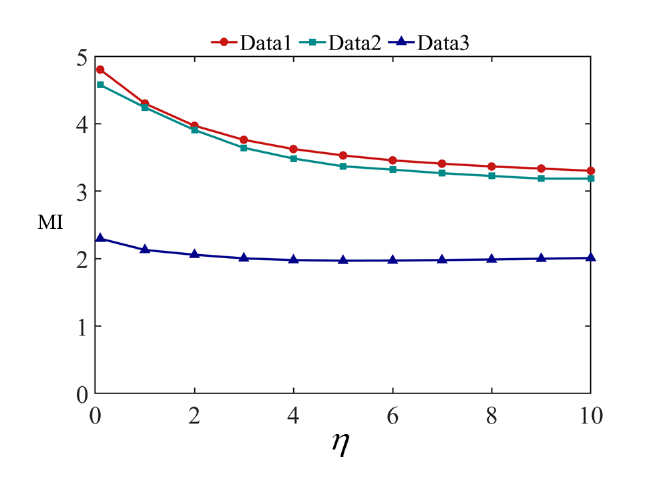
Figure 14. EN evaluation results at different η values.